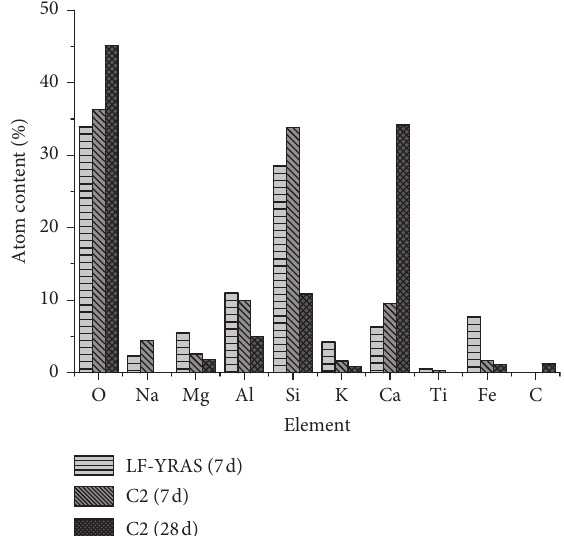
Figure 8: Element contents of gels in LF-YRAS (curing for 7d), C2 (curing for 7d), and C2 (curing for